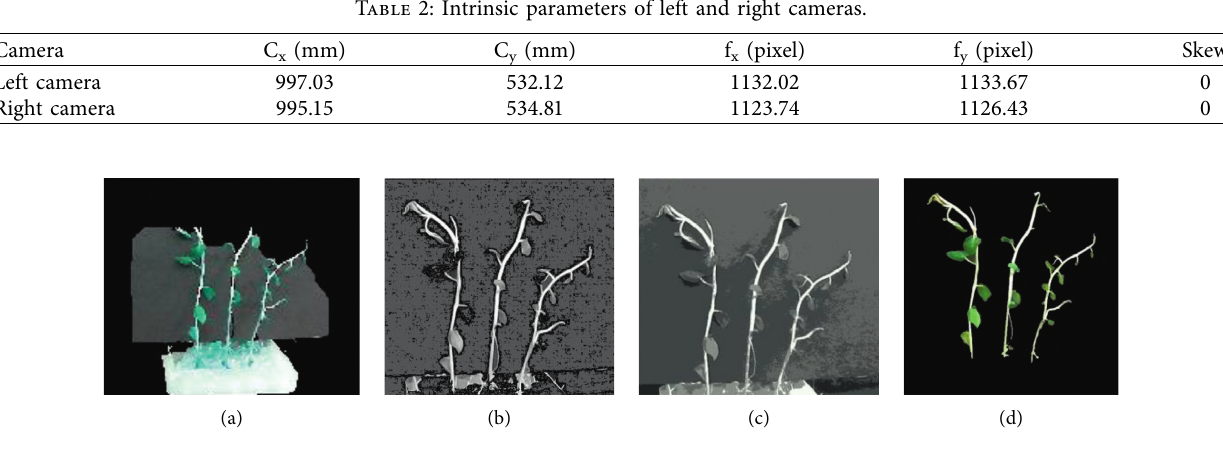
Figure 7: Segmentation algorithm comparison. (a) GrabCut. (b) Regional growth. (c) FCM clustering. (d) The present